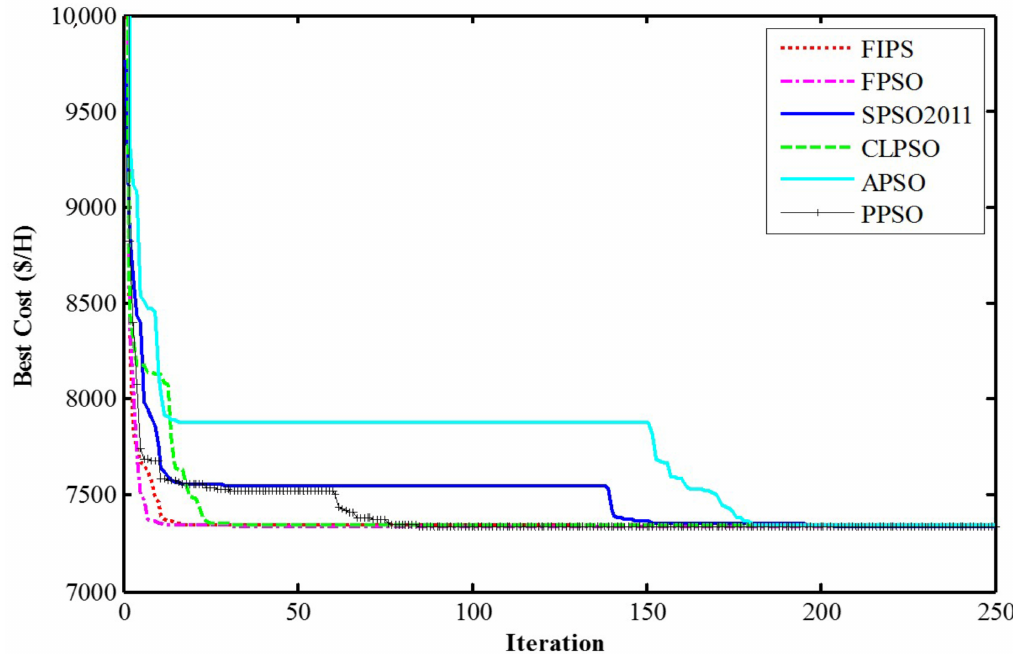
Figure 4. Convergence graphs of different PSO algorithms for the medium-scale test system.